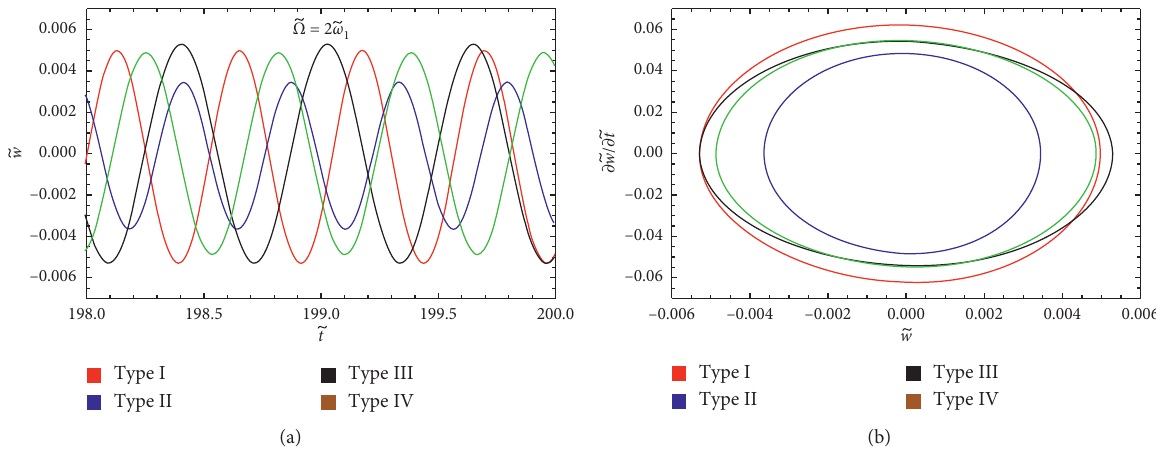
Figure 5: Time histories and phase diagrams of the transverse motions 􏽥 w of BDFG beams as 􏽥 Ω � 2 􏽥 ω